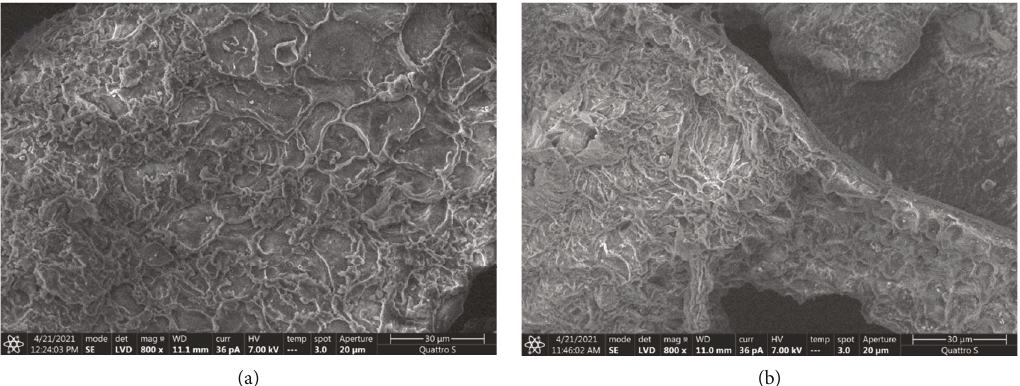
Figure 5: The SEM images of biosorbent (a) before adsorption of MG and (b) after adsorption of MG.